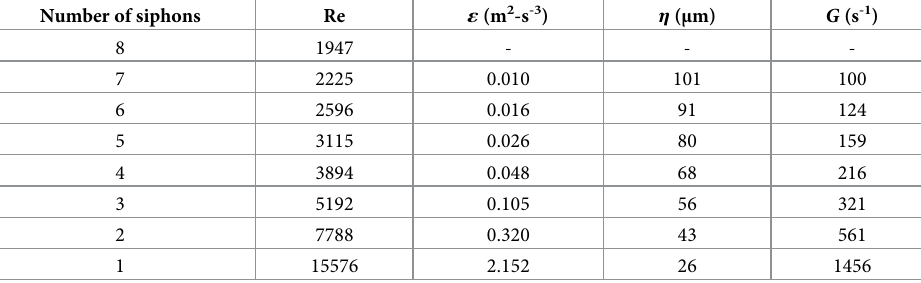
Table 2. Siphon flow conditions used in the floc breakup